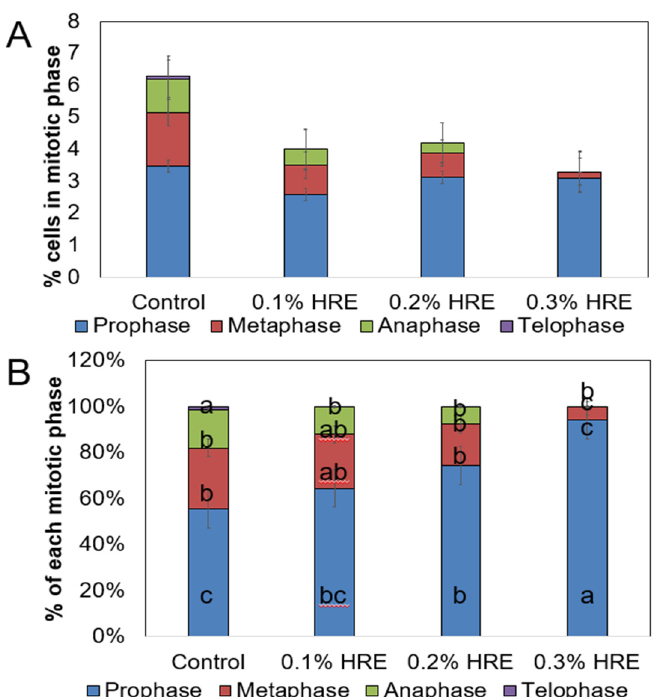
Figure 2. The percentage of cells in each mitotic phase was revealed after 3 days of treatment ( A ), and the percentage of each mitotic phase among the mitotic cells was also evaluated ( B ). HRE treatment was performed at 0% (control), 0.1%, 0.2%, and 0.3% concentrations. Different letters indicate significant difference among treatments by least significant difference test at p = 0.05.